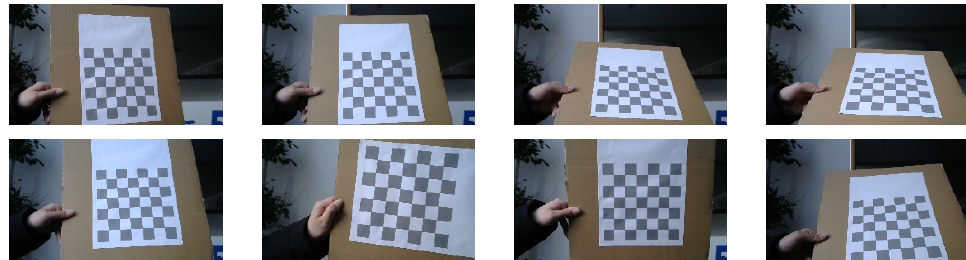
Figure 14. Calibration of the camera’s internal parameters.